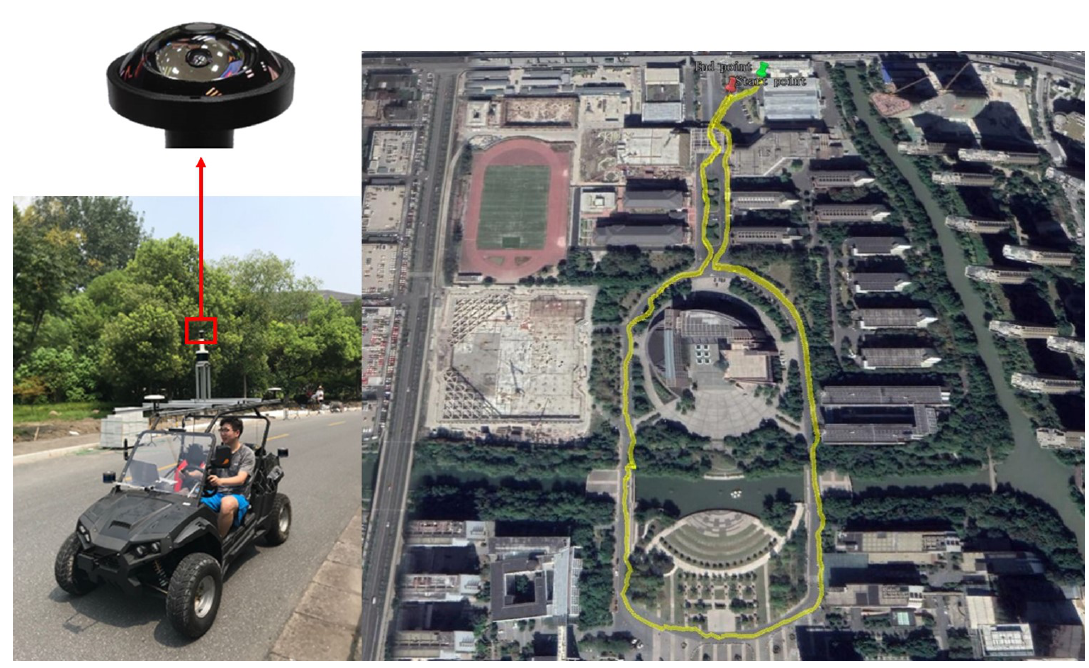
Figure 8. The trajectory of the navigation route and the fully electric instrumented